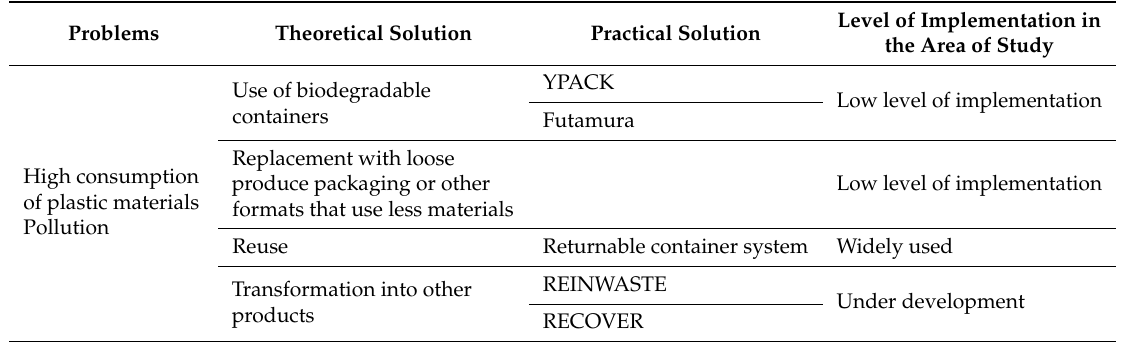
Table 8. Main solutions based on the CE for packaging.